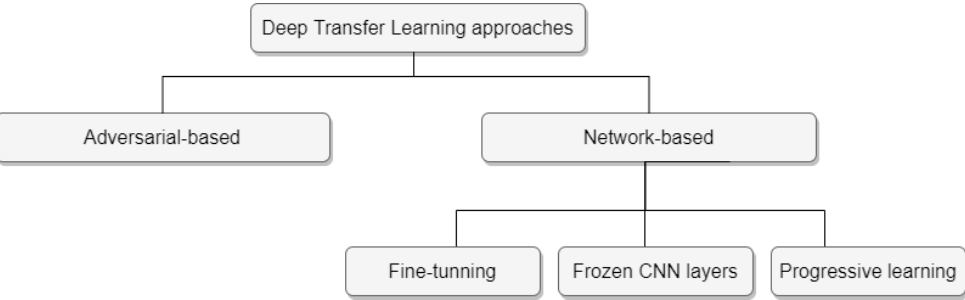
Figure 2. Most common Deep Transfer Learning approaches.